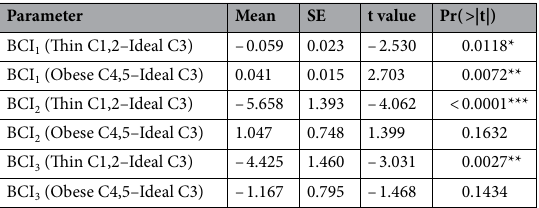
Table 4. BCI and b values fitted to wild Antillean manatees with non-linear robust regression. (* = p < 0.05; ** = p < 0.005; *** = p < 0.0005).